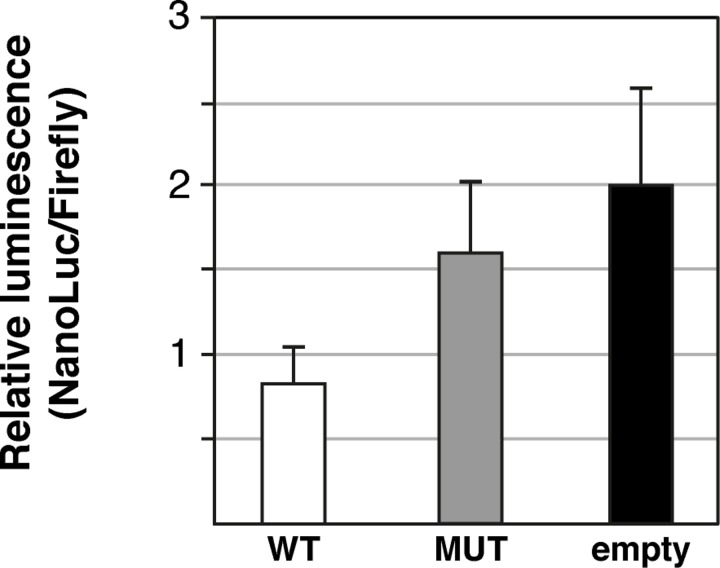
Reporter assay indicates the variant site might be a silencer.Dual luciferase assay with MDCK cells transfected with wild-type (WT), mutant (MT) and empty vectors indicated robust reduction in relative luciferase activity when comparing the wild-type constructs to empty vector, supporting the putative silencer activity (p < 0.05). Relative luciferase activity was significantly increased in mutant versus wild-type constructs (p < 0.05), indicating the type 1 PRA associated variant disrupts the putative silencer activity, but might not prevent it completely.